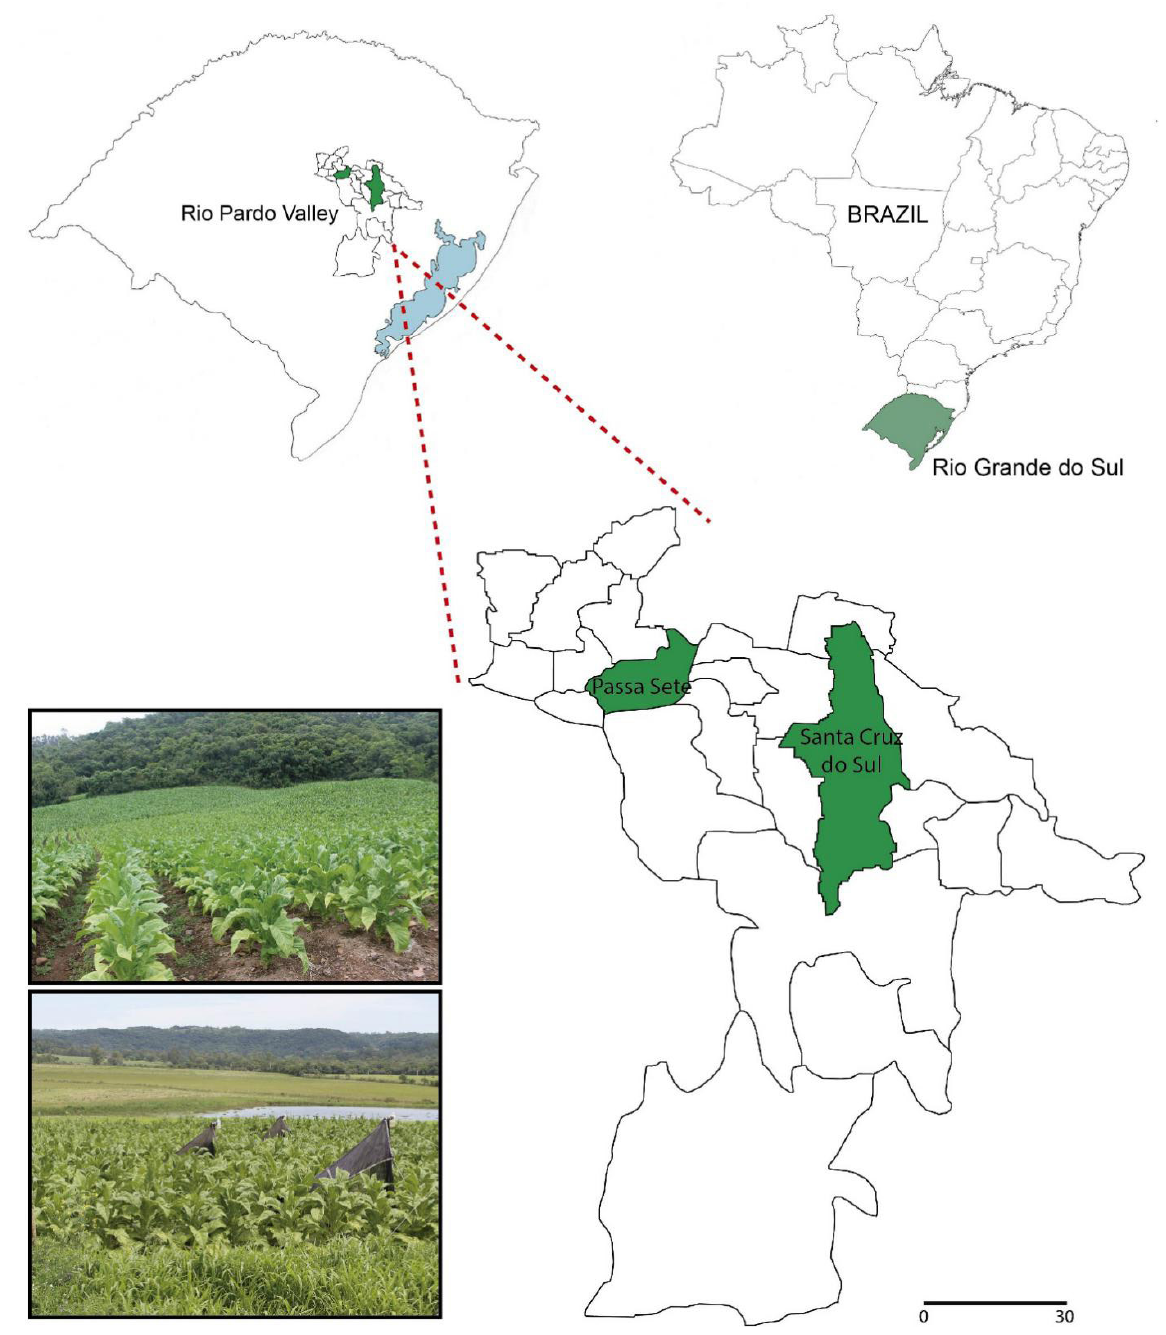
Fig 1 . Location of study areas at national, state and municipal levels. Left images of tobacco crops under organic management. Source: Modified from Laboratory of Geoprocessing of the University of Santa Cruz do